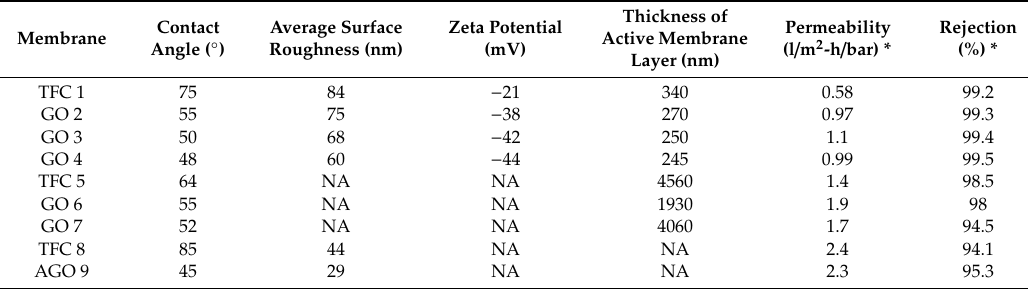
Table 14. Characteristics and performance of TFC and GO-functionalized TFC membranes from di ff erent studies by Ali, et al., Huang et al., and Chae et al.